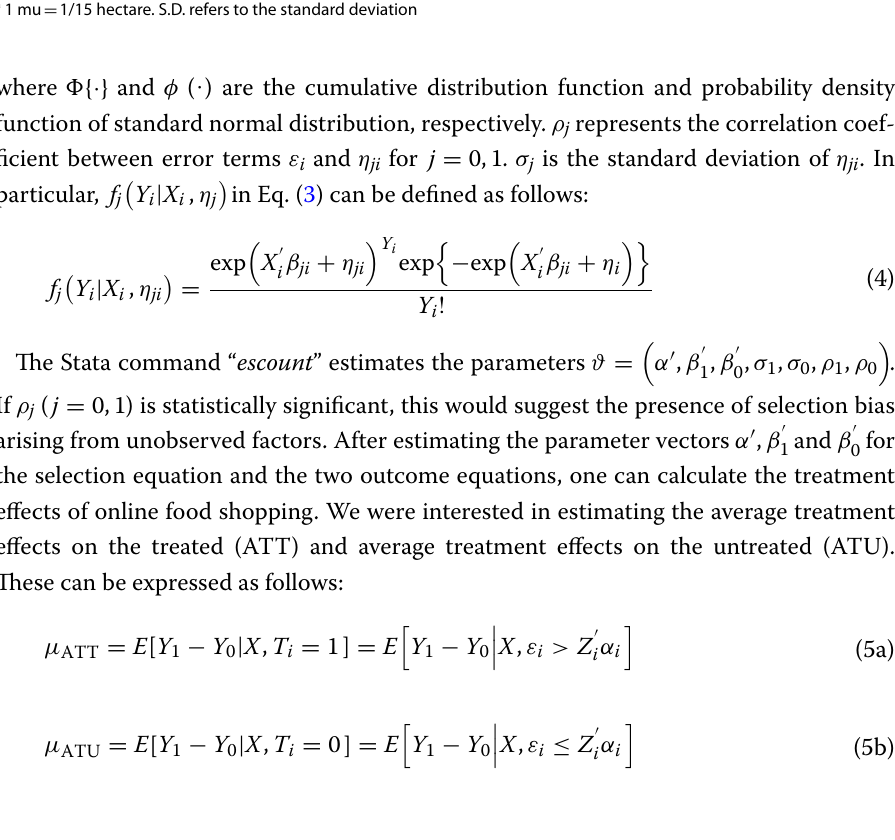
a 1 mu 1/15 hectare. S.D. refers to the standard =